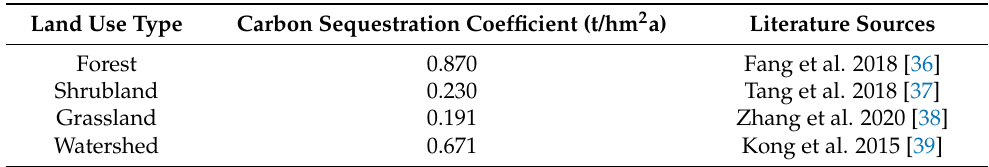
Figure 4. An optimization model for synergistic enhancement of ecological functions and carbon sinks. Table 1. Carbon sequestration coefficient for different land use types.